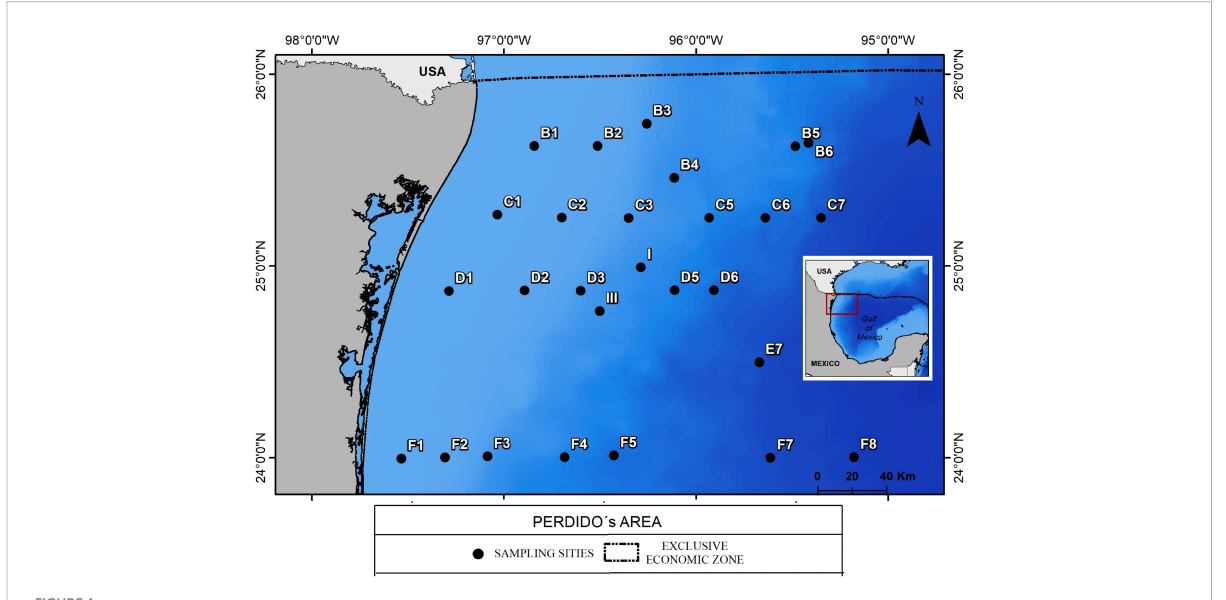
FIGURE 1 Map of the study zone showing the sampling stations (black dots) and